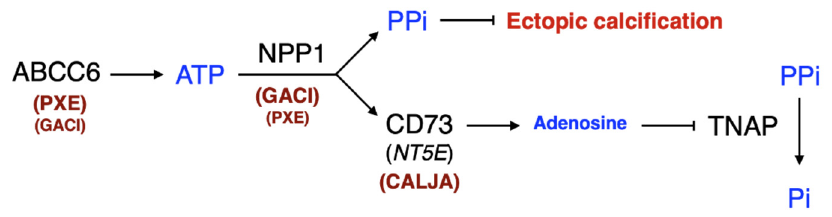
Figure 1. The ABCC6 pathway influences calcification and extracellular purinergic metabolism. ABCC6 facilitates the cellular efflux of ATP from liver and other tissues/cells, which is quickly converted to pyrophosphate (PPi), a potent inhibitor of mineralization. Decreased plasma PPi levels cause calcification in PXE and GACI. CD73 activity leads to adenosine production, which affects many biological activities including the inhibition of TNAP synthesis. TNAP degrades PPi into inorganic phosphate (Pi), an activator of calcification, which leads to vascular calcification in CAL JA patients.